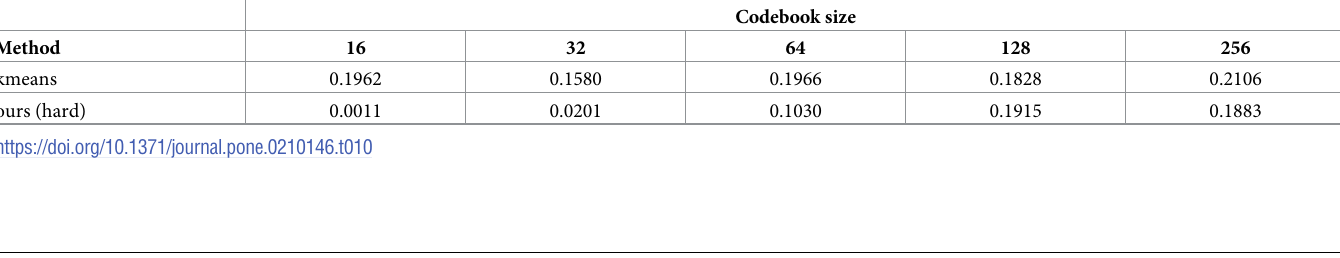
Codebook size K